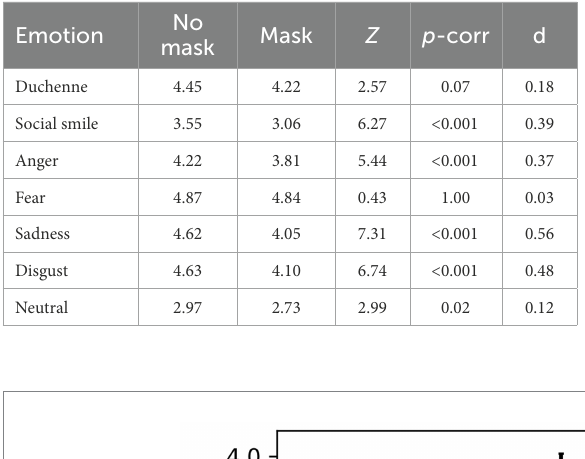
TABLE 3 Mean scores of the ratings how intense the participants perceived the displayed emotion without and with facial mask, the result from the Wilcoxon test and effect sizes (Cohen’s d).